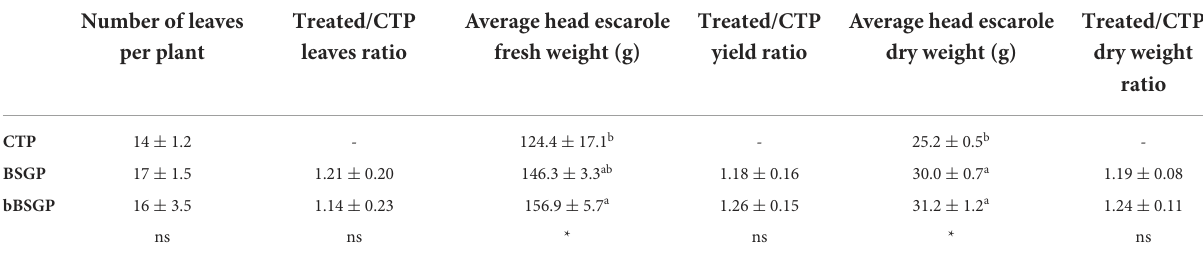
ns, notsignificant. TABLE 3 Biometric features of escarole plants, grown in soil unamended (CTP) and amended with native (BSG) or bioprocessed brewers’ spent grain (bBSG), at the end of the trial. Number of